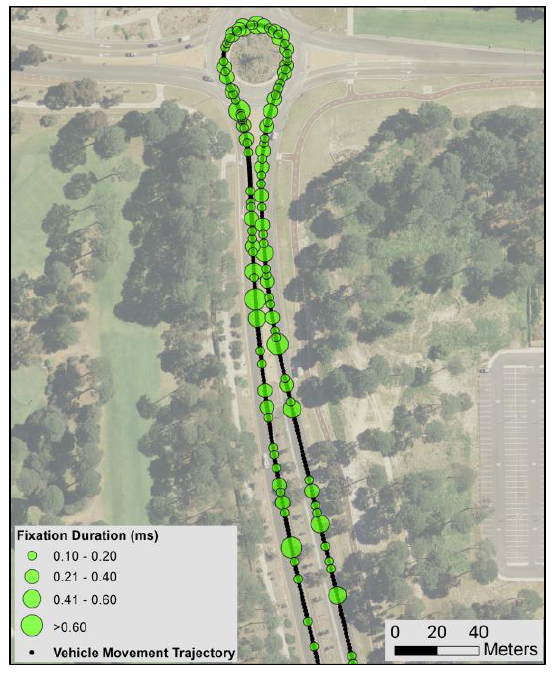
Figure 9. The spatial distribution of eye fixation behaviour at a roundabout U-turn and straight road driving from one driver.